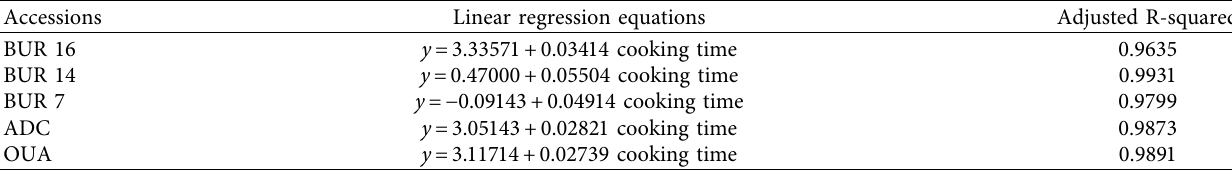
Table 1: Parameters of linear regression equations of the fve accessions texture according to the cooking